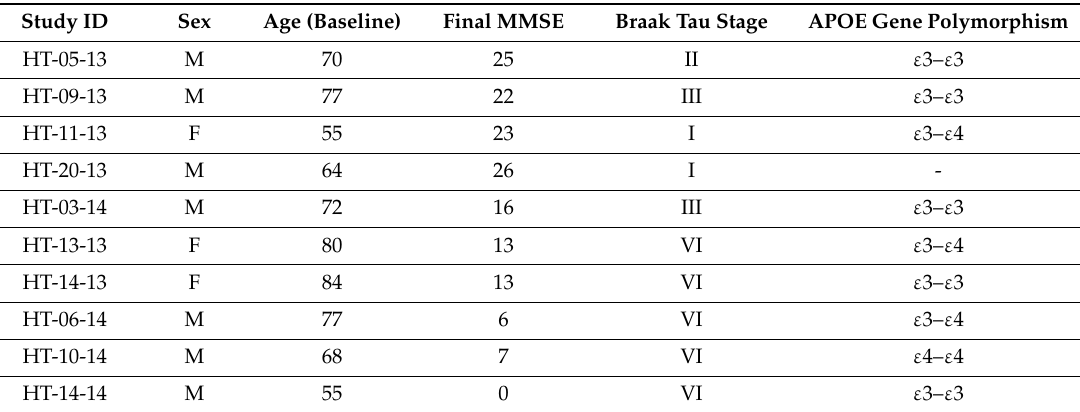
Table 1. Human postmortem samples: case identifier (study ID), age (baseline), sex, final MMSE score, neuropathological Braak tau stage and APOE gene polymorphism. (M: male; F: female; MMSE: mini-mental state examination; APOE: apolipoprotein